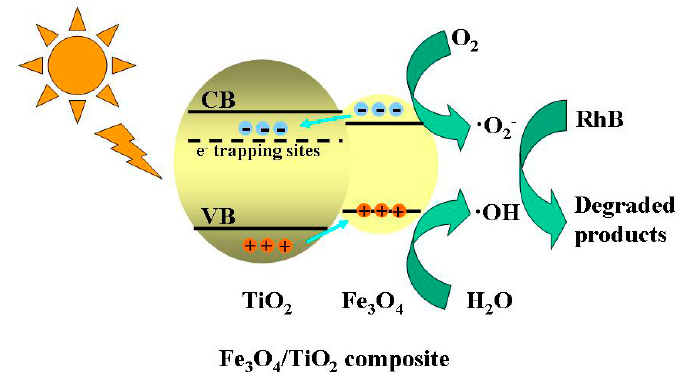
Scheme 2. The schematic diagram of the proposed photocatalytic mechanism of RhB for Fe 3 O 4 /TiO 2 nanocomposite.